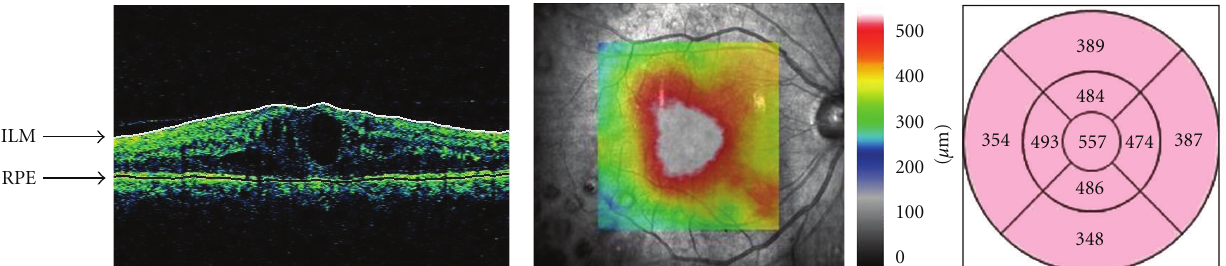
Figure 2: (Top) Macular cube 200 × 200 mode with SD-OCT. (Bottom) The mean retinal thickness at the central 1mm circle is 557 µ m in the same 74-year-old